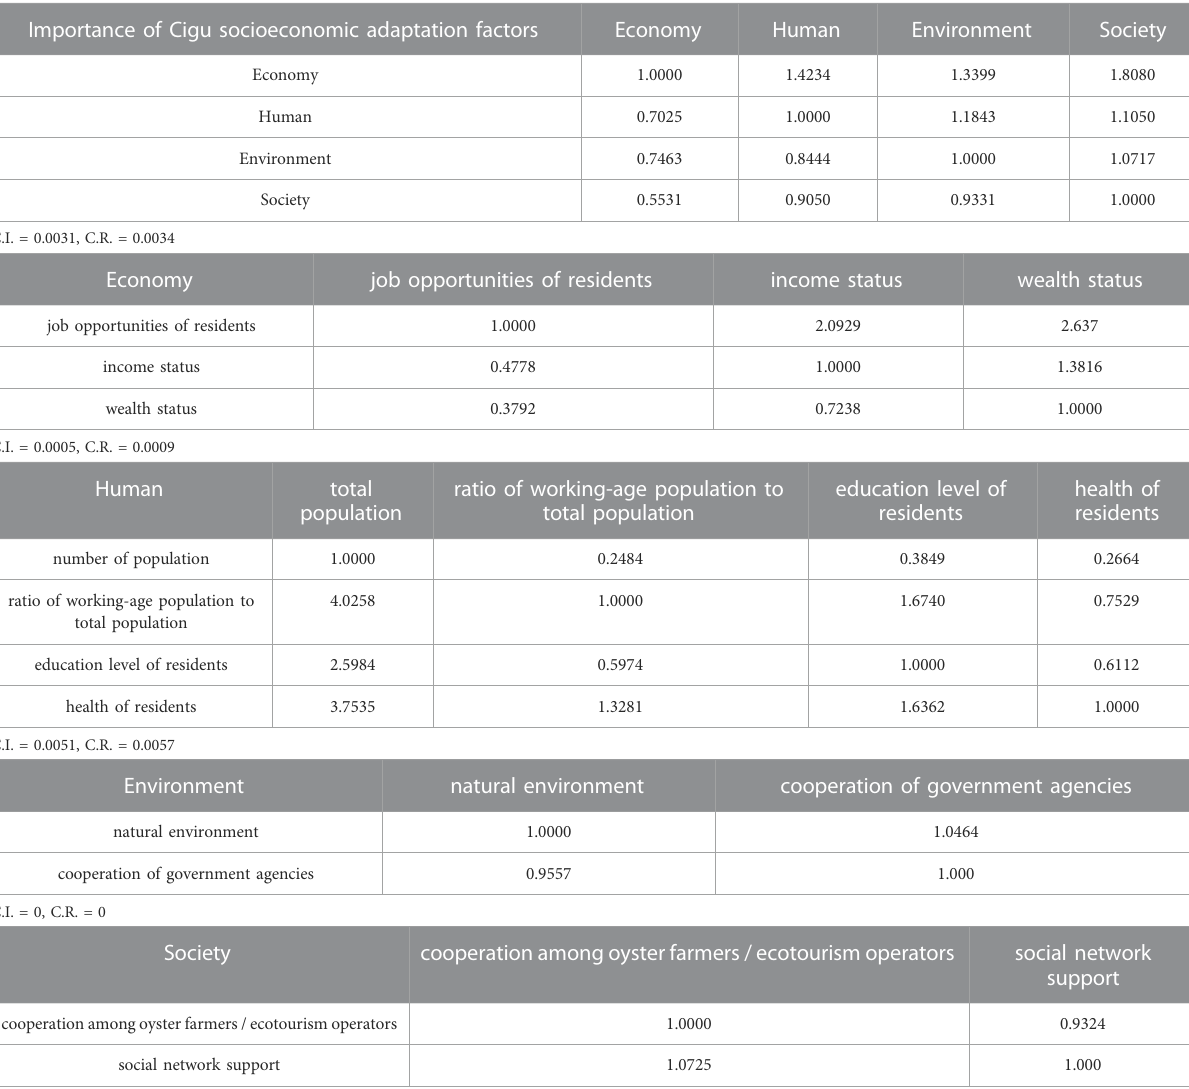
TABLE 3 Pairwise comparison